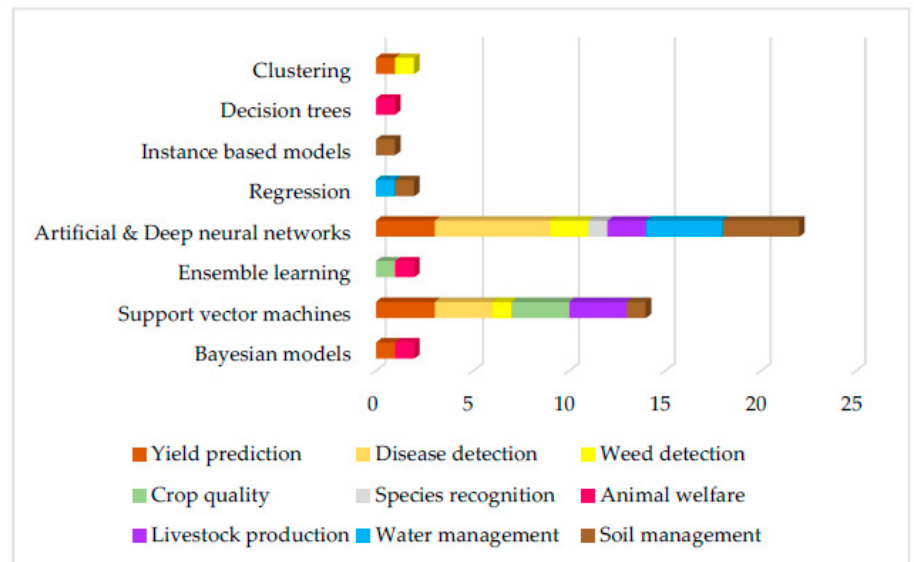
Figure 4. The total number of ML models according to each sub ‐ category of the four main categories.